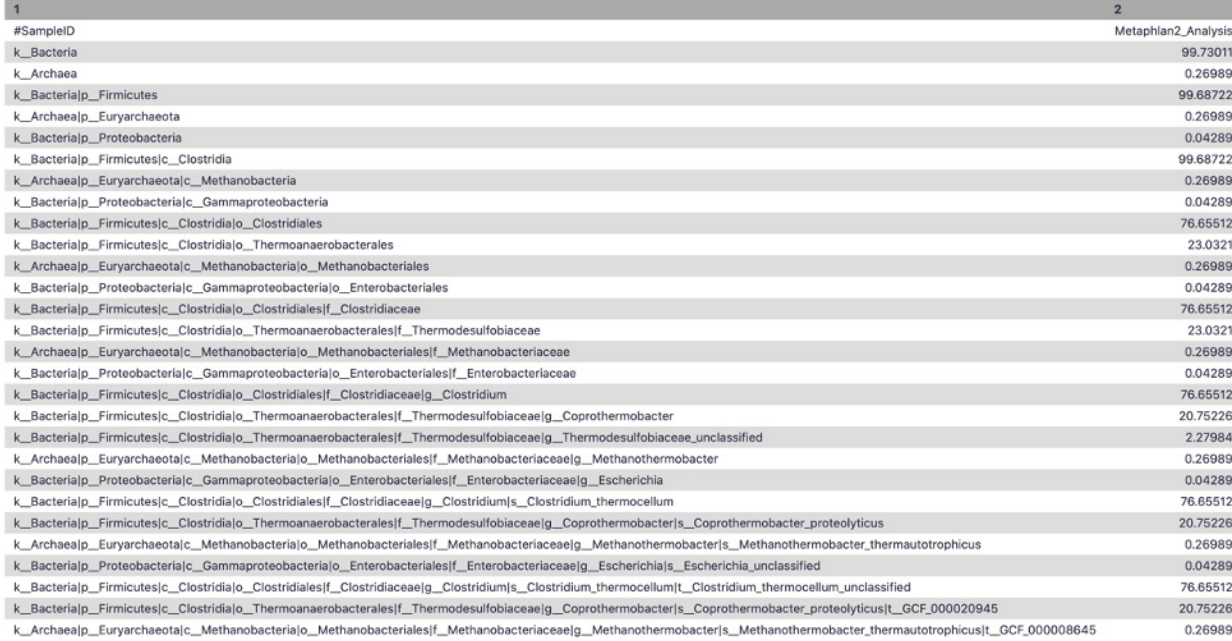
Figure 4. MetaPhlAn2 community profile. A tabular representation of MetaPhlAn2 community profile displaying the different levels of taxonomic classification and its relative abundance at that level.